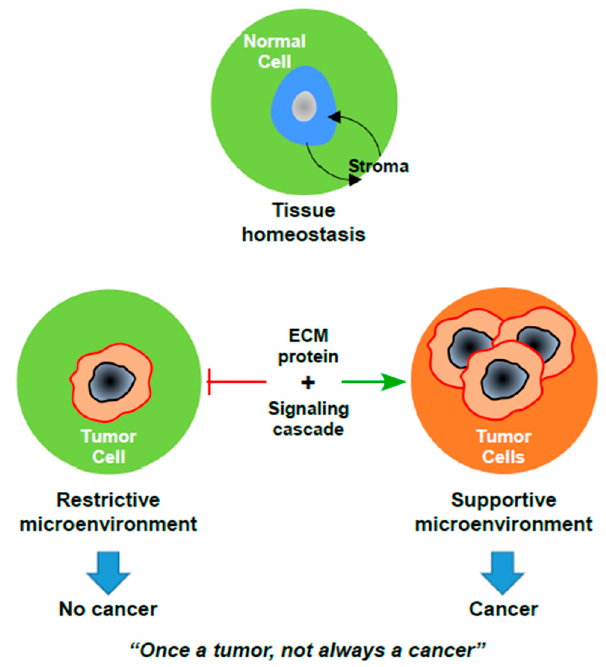
Figure 1. The paradox of cancer development. Upon loss of tissue homeostasis, the progression of an occult tumor to frank carcinoma requires significant changes in the microenvironment. ECM: Extracellular